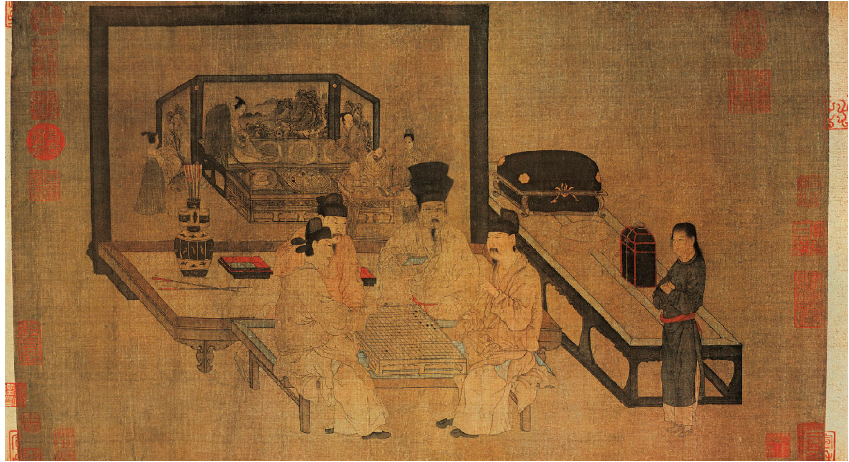
Figure 6. Zhou Wenju (Five Dynasties) Playing Chess beside Double Screen . Ink and colors on silk. (70.5 × 40.3 cm) Palace Museum Collection, Beijing.